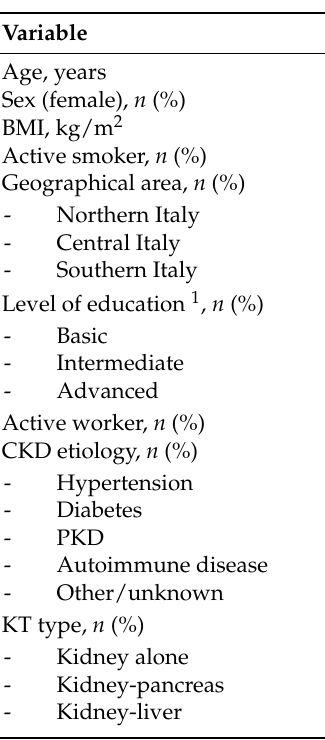
Table 1. Participant